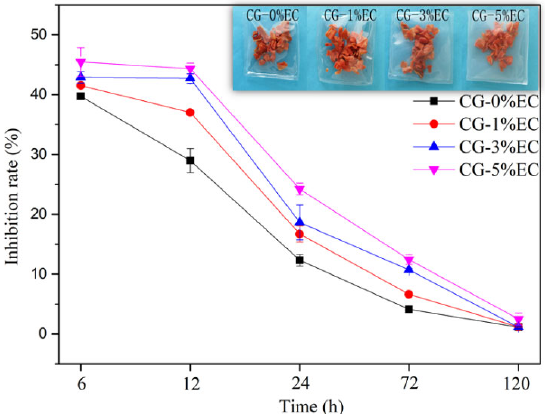
Figure 9. The effects of time on inhibition rates of water absorption of carrot cubes packaged by different films.